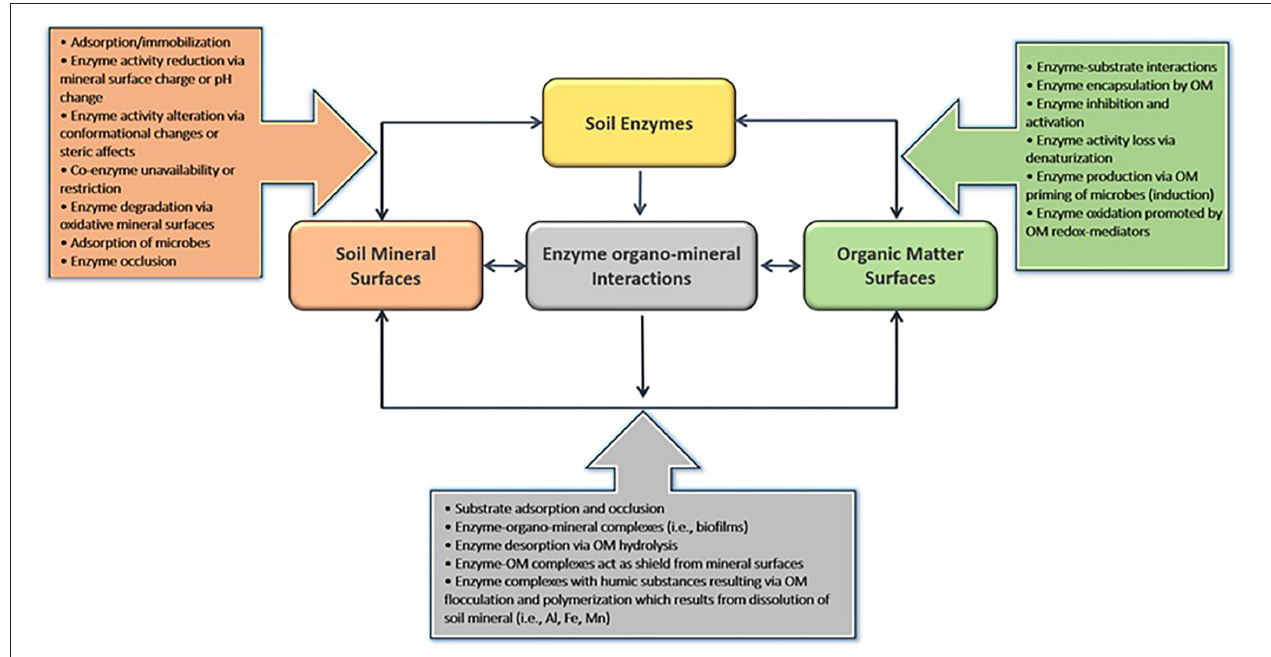
FIGURE 3 | A summary of the interactions between soil colloidal and organic matter surfaces and extracellular enzymes and their effect on enzyme–substrate complex